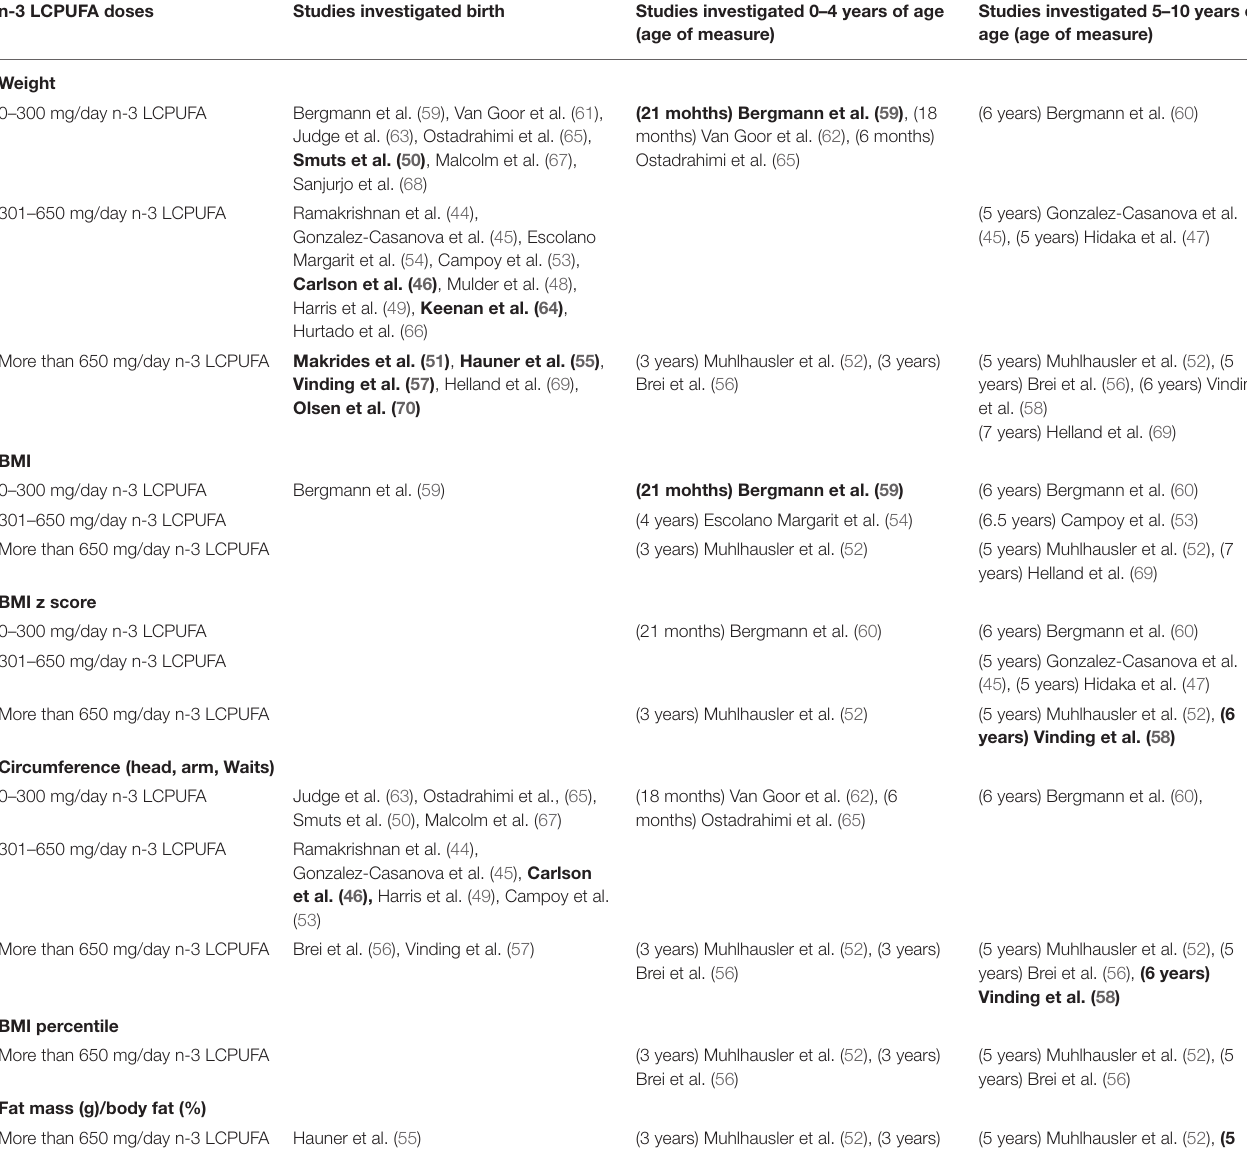
TABLE 2 | Summary of outcomes reported in the included